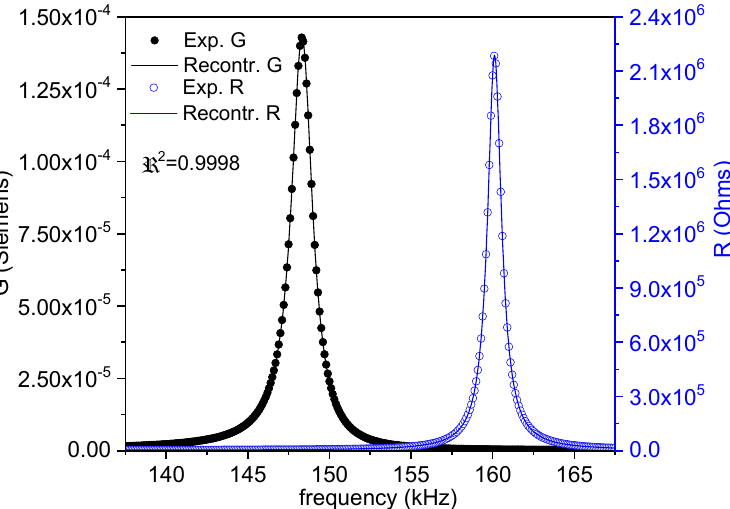
Figure 4. Fundamental length extensional resonance of a thickness-poled and excited cylinder. The impedance spectra in an ( R , G ) plot of a cylinder with a 6 mm diameter and 15 mm length. The symbols are the experimental data, and the lines are the reconstructed peaks after the calculation of the coefficients. The value of the regression factor for this calculation ( ℜ 2 ) is shown. The black symbols and lines ( G data) can be read in the left-y-axis, and the blue ones ( R data) are in the right-y-axis.